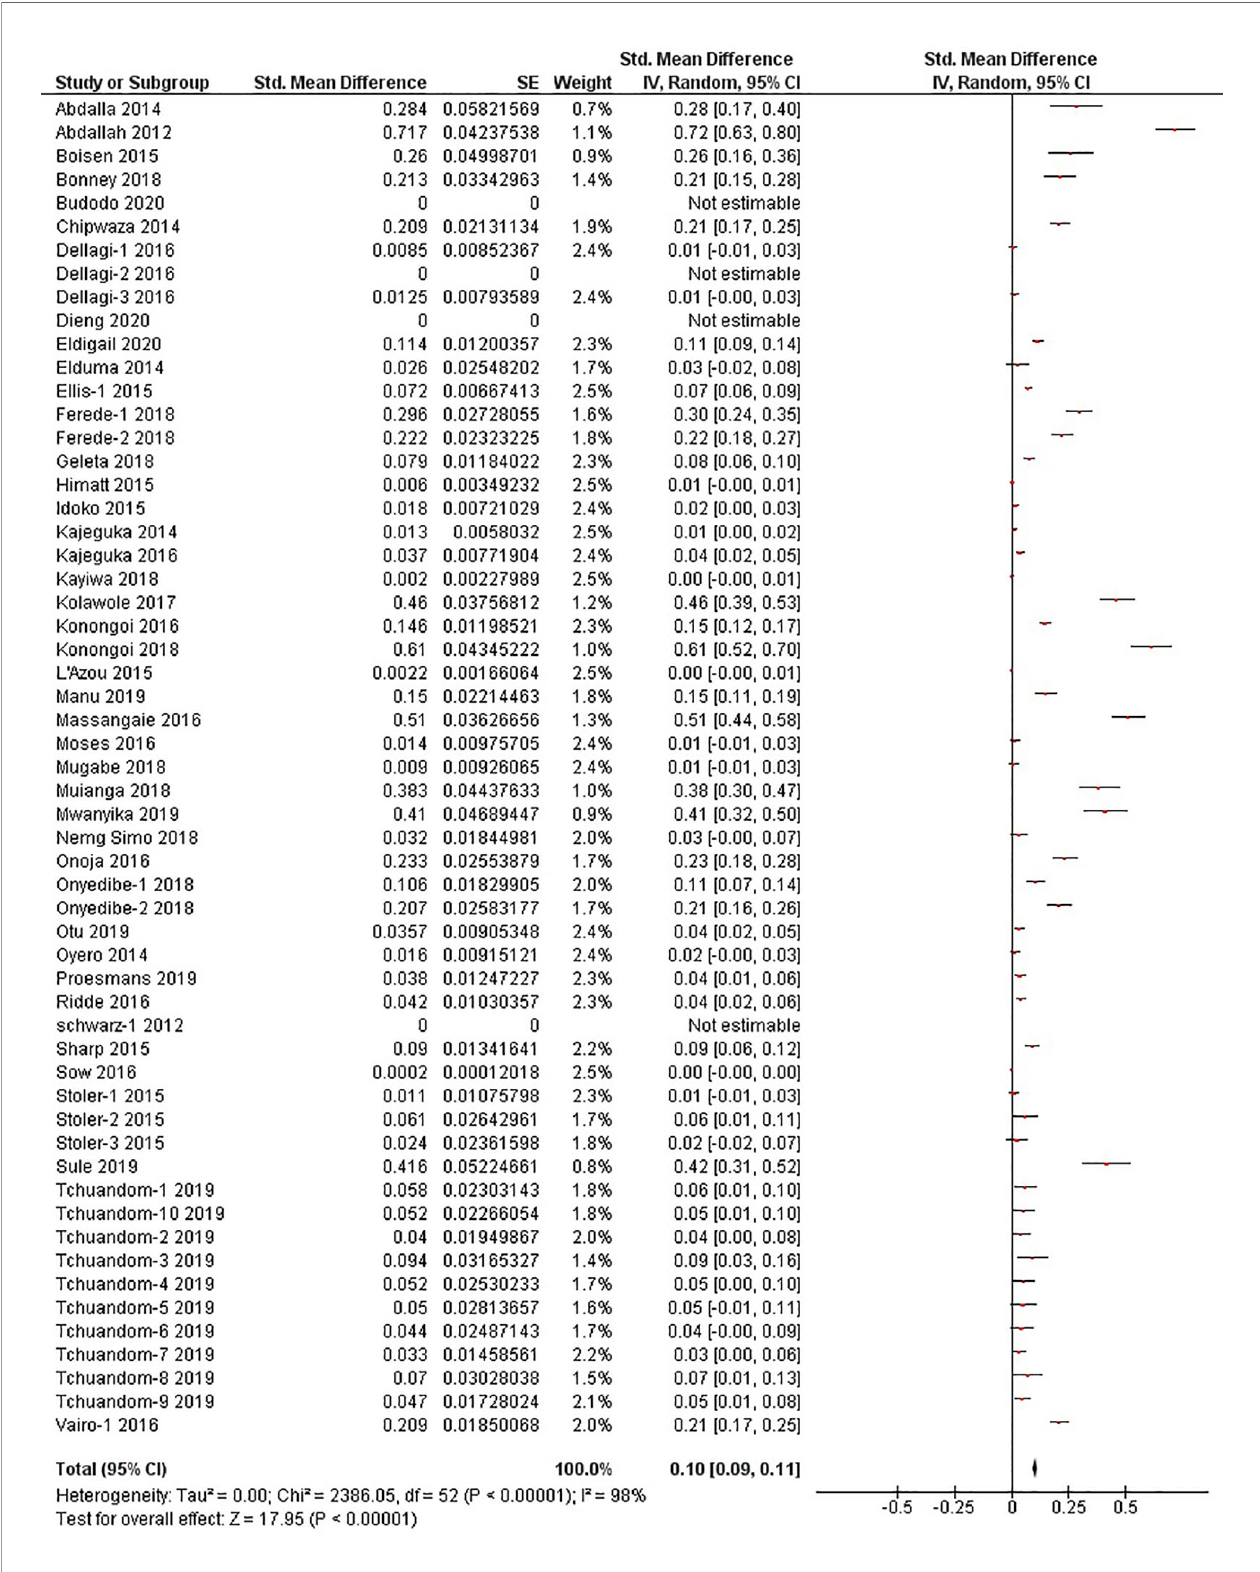
FIGURE 4 | The pooled sero-prevalence of Dengue Virus Immunoglobulin M (IgM) in Sub-Saharan African population between